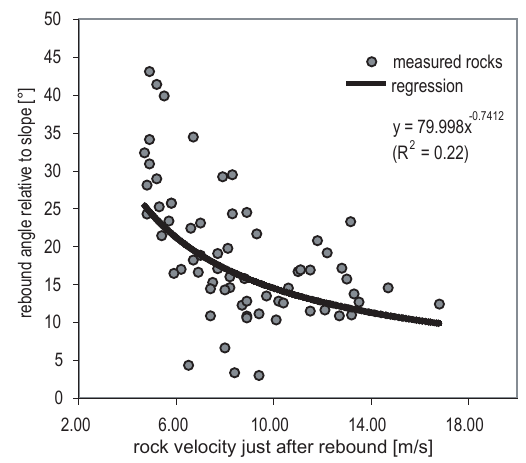
Fig. 5. Relationship of rebound angle and velocity just after re- bound for 63 recorded rebounds on the unforested Site 1 in